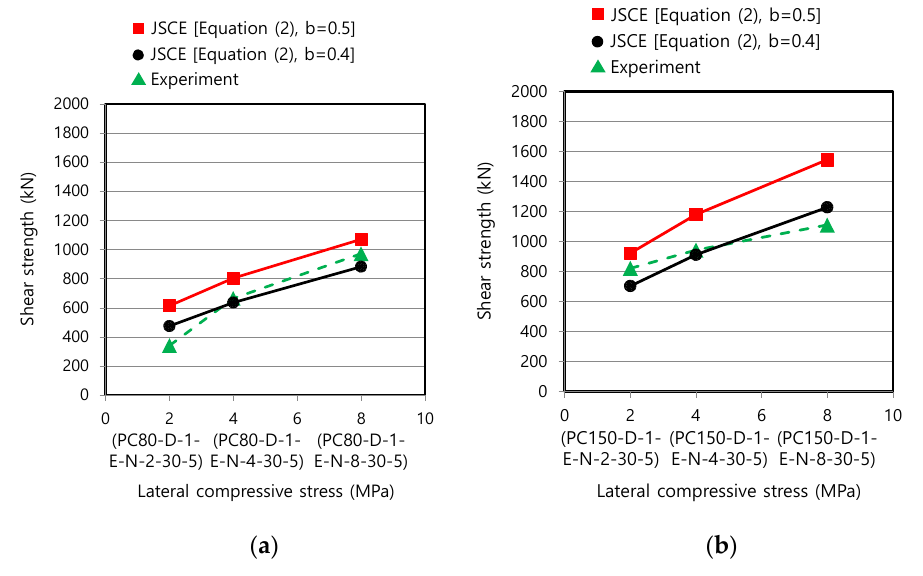
Figure 9. Comparison of test data with predictive equation of JSCE [22,24] (dry joint with epoxy): ( a ) specimens with f ′ = 80 MPa; and ( b ) specimens with f ′ = 150 MPa.